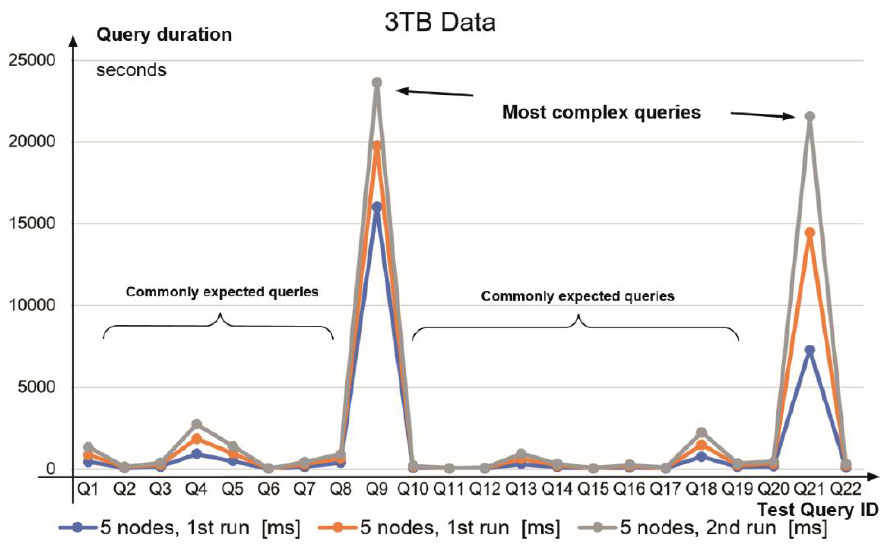
Figure 8. TPC-H query duration on 3 TB test database (queries Q1 to Q22).